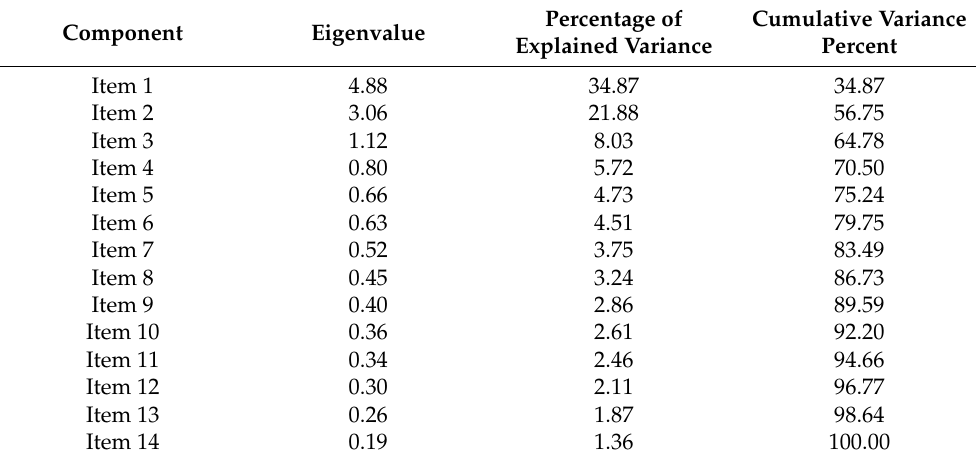
Table 2. Principal Component Analysis (PCA): eigenvalue, percentage of explained variances of a single component, and cumulative variance percent.